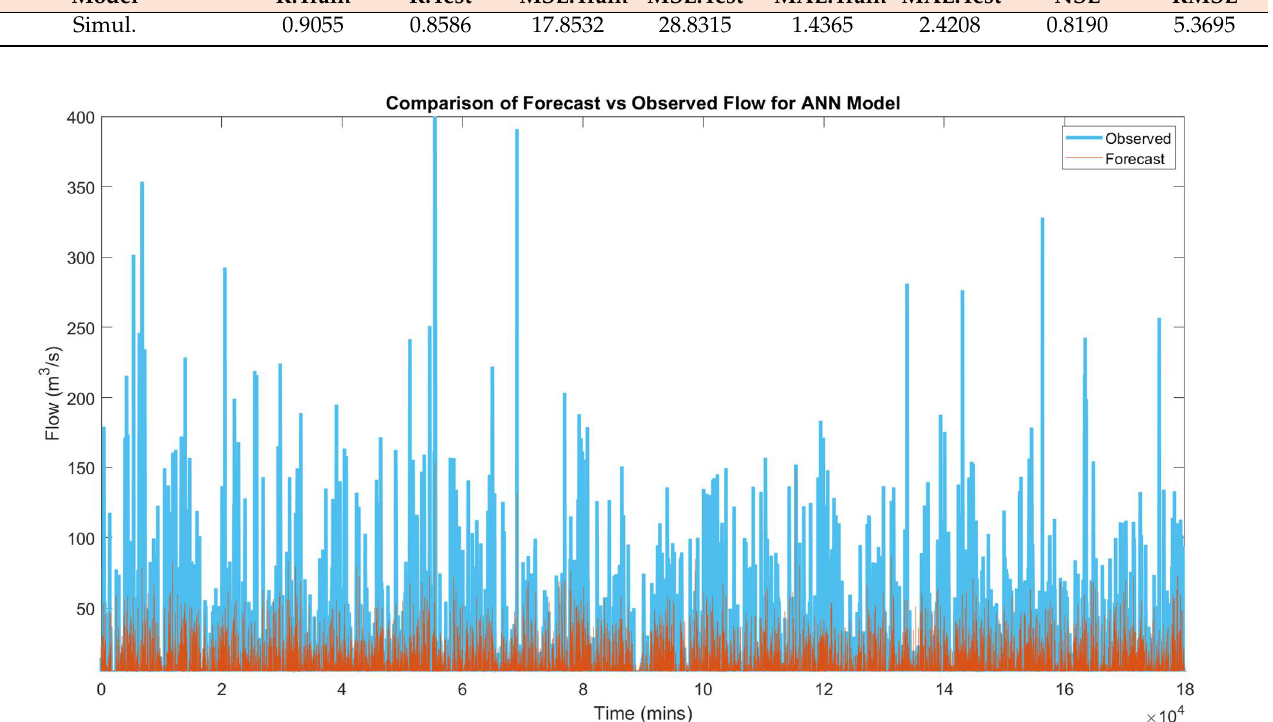
Figure 7. Graph of ANN model observed flow vs. simulated flow.